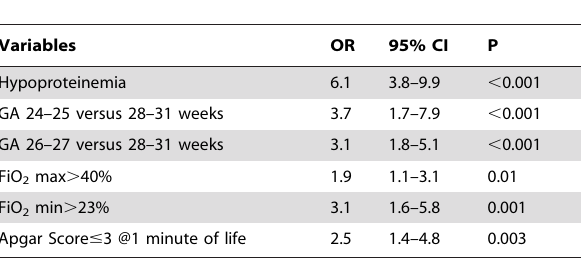
Table 2. Variables associated with severe adverse outcome at multivariate analysis in the study population (n=761 preterm infants , 32 weeks